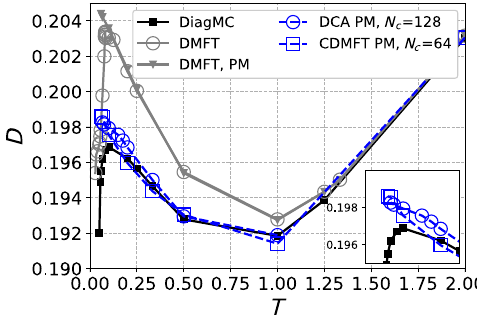
FIG. 13. Results for the double occupancy from DMFT, DCA, and CDMFT compared to DiagMC. For DMFT, we display both the (metastable) solution obtained by constraining the system not to order (PM) and the lower free-energy solution with AF magnetic ordering. The zoom in the inset confirms the absence of a downturn in the cluster techniques when constrained to the PM solution due to the insufficient cluster